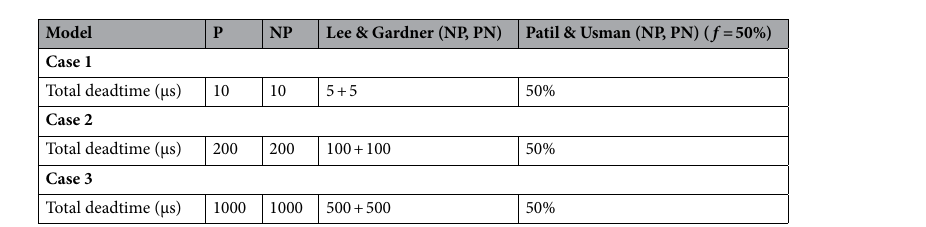
Figure 1. Different deadtime behaviors according to five models. ( OriginPro 2020b, https ://www.origi nlab. com/2020b Annou nceme nt).